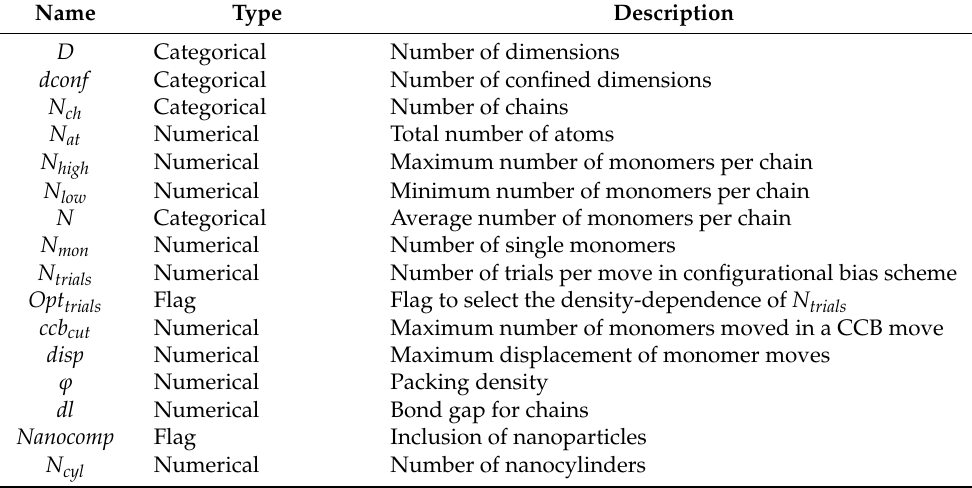
Table A1. Summary of the main variables as used by the Simu-D suite. Dashed line separates variables of the simulator and descriptor